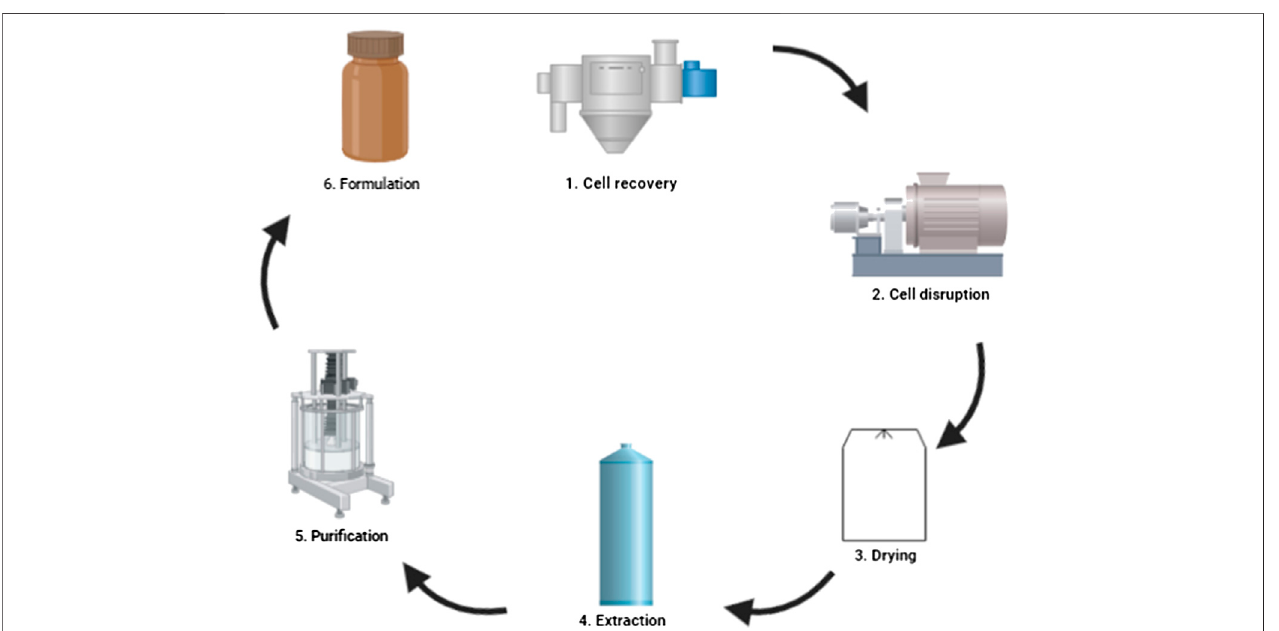
FIGURE 2 | Downstream processes for N-ASX